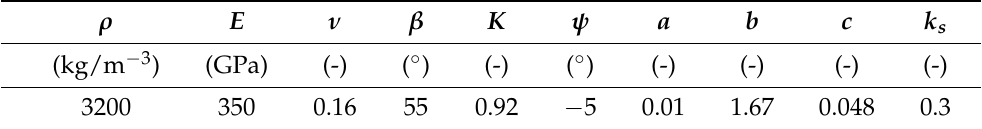
Table 1. The parameters for the DP model and the damage model used for nanoindentation and cutting simulations of 3C-SiC. The quantities ρ , E , ν represent density, Young’s modulus and Poisson ratio, respectively, which were included in this table for completeness as they were used in the FE simulations. The friction angle is β , and the dilation angle is ψ . The damage parameters a , b , and c , defined in Equation (6), as well as the parameters ν , K , and k s are dimensionless. The Young’s modulus and Poisson ratio was adopted from Pabst et al. [27] and Fu et al. [28], respectively, with small